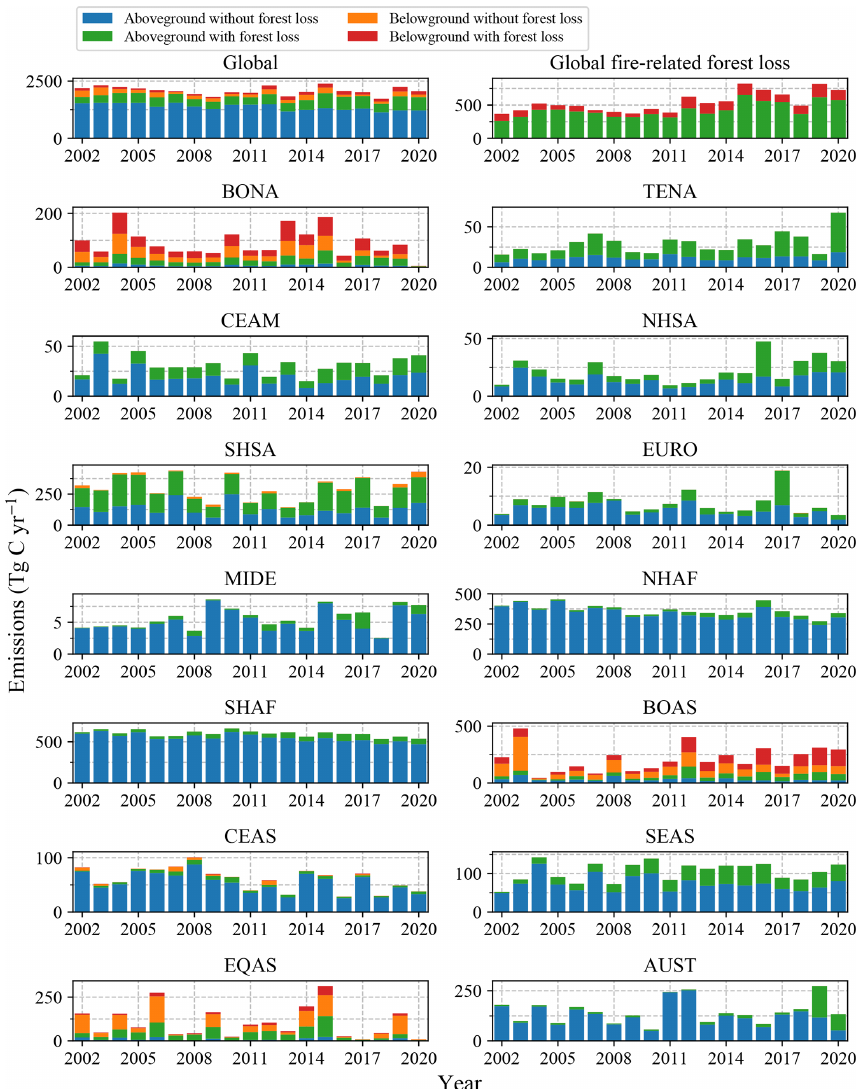
Figure 7. Annual 2002–2020 emissions for the global total, global fire-related forest loss, and the 14 GFED regions. Bars are subdivided into aboveground and belowground emissions and into fire without forest loss and with forest loss (i.e. fire-related forest